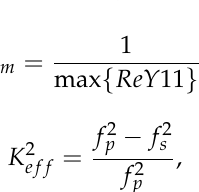
Figure 11. Admittance curves of the resonator under three successive overtones (( a ) third − order over ‐ tone, ( b ) fifth − order overtone, and ( c ) seventh − order overtone).